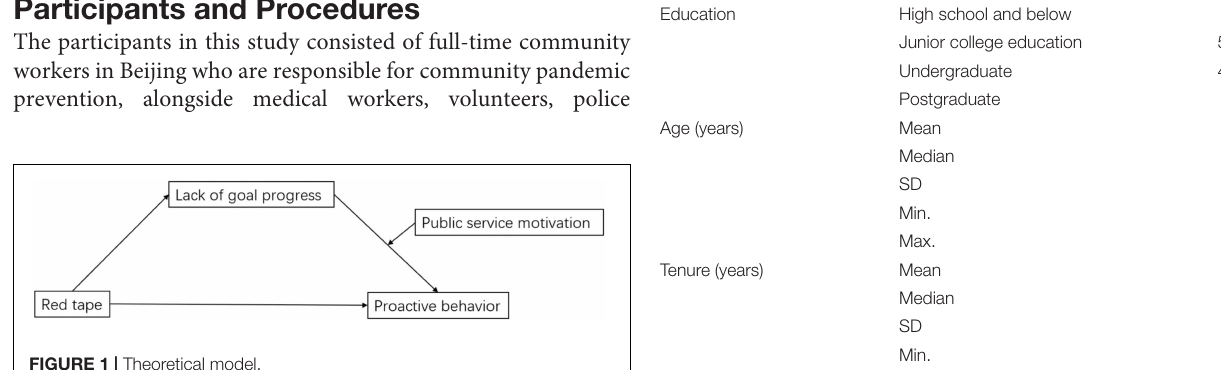
FIGURE 1 | Theoretical